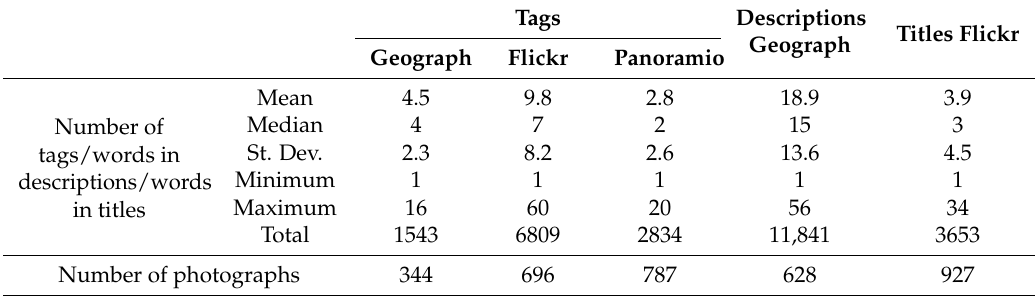
Table 5. Analysis of the tags associated with the geo-tagged photographs in Geograph, Flickr and Panoramio and the descriptions and titles for Geograph and Flickr. Tags